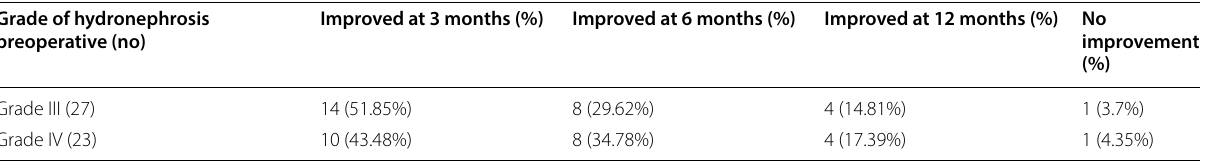
Table 2 Grades of hydronephrosis preoperative and time of improvement Grade of hydronephrosis preoperative (no)